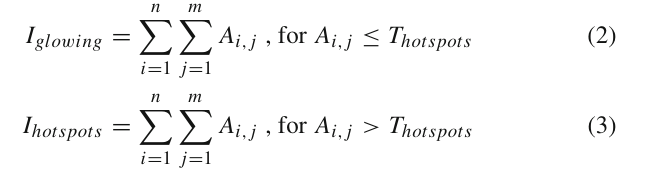
shows examples of the current-voltage characteristics of both SiPMs at dark